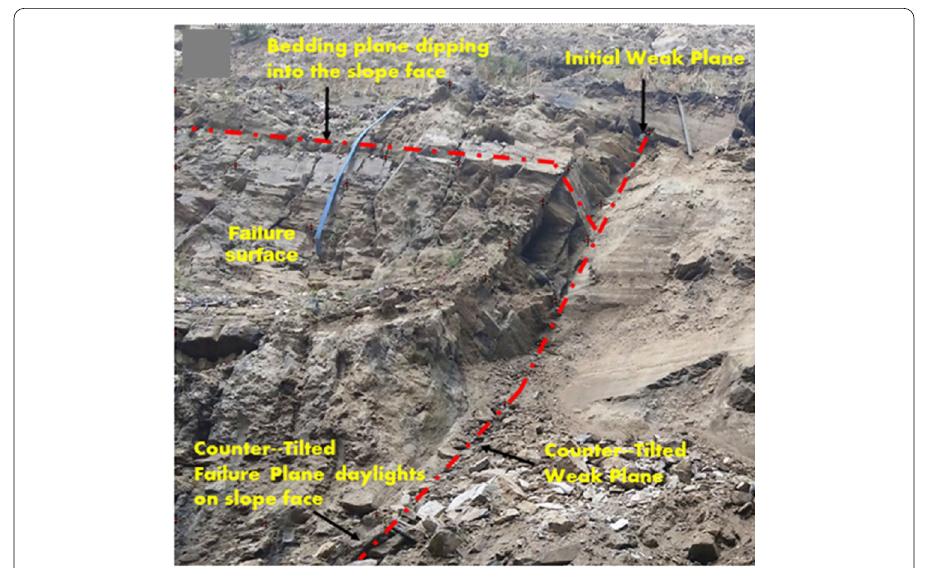
Fig. 7 Post-failure photograph of slide head toppling of Northwall of the Nchanga Open